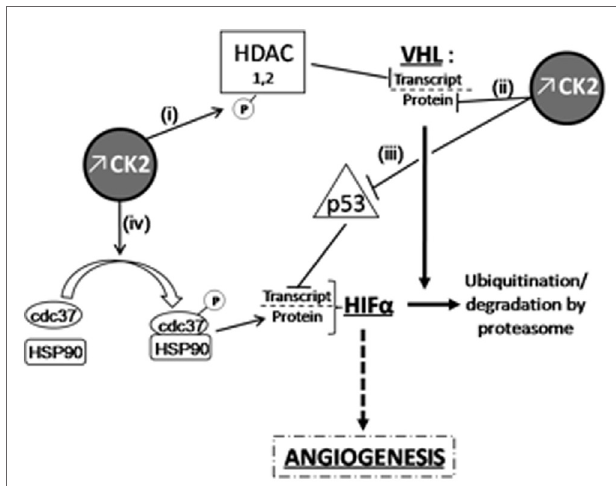
FiGURe 1 | Overexpressed CK2 induces HiF α accumulation through vHL-dependent or independent mechanisms . CK2 can down-regulate VHL expression at the transcriptional level (i) by phosphorylating HDACs (125) as well as at post-translational level and (ii) by destabilizing phosphorylation in the NH 2 -terminal acidic domain of VHL (126). In the latter case, CK2-induced destabilization of VHL also results in p53 inactivation, which can no longer inhibit HIF α transcription (iii); (126, 127). Finally, (iv) cdc37 phosphorylation by CK2 allows HSP90/cdc37 dimer formation and the subsequent interaction of this complex with HIF-1 α , which is essential for its cellular stability (128,